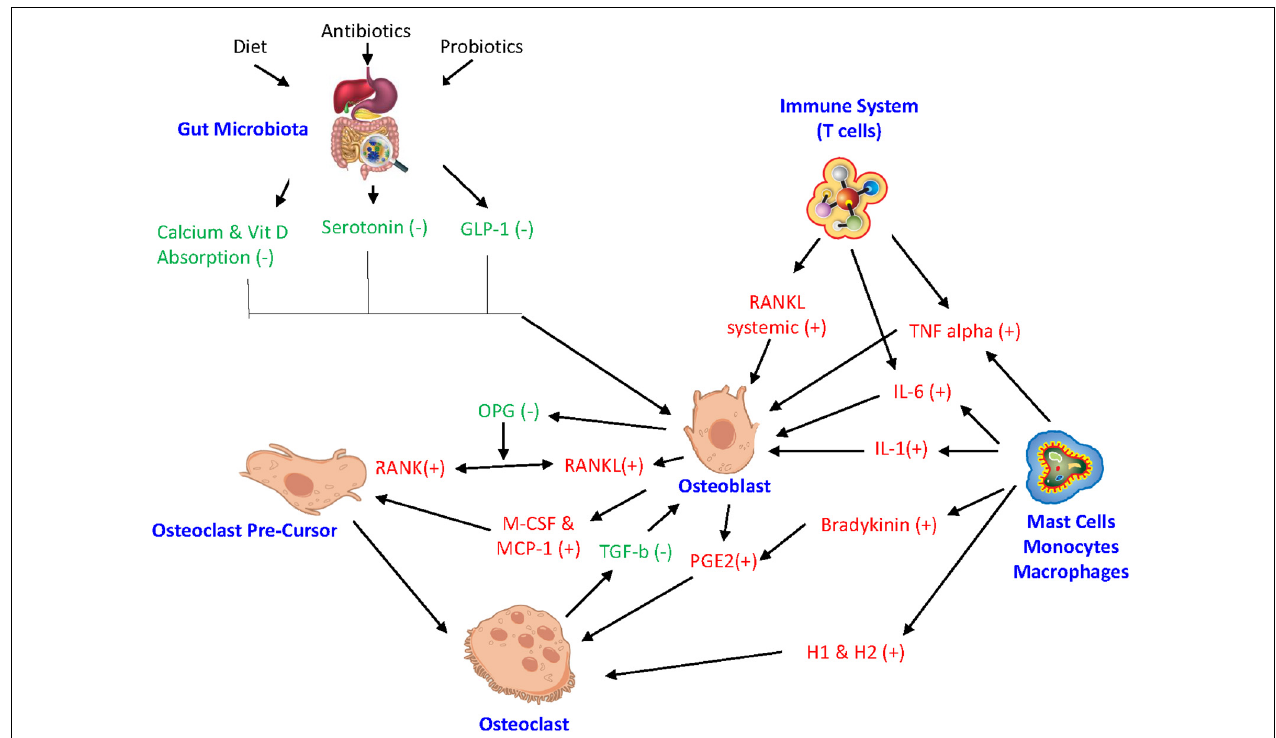
FIGURE 2 | Integrated inflammatory model. The complex link between gut microbiota, hormonal pathways, immune system, and bone turnover. GLP-1 glucagon-like peptide, miRNA microRNA, IL-6 interleukin-6, IL-1 interleukin-1, RANKL receptor activator of NF-kB ligand, RANK receptor activator of nuclear factor-kB, OPG Osteoprotegrin, TNF alpha tumor necrosis factor-alpha, M-CSF macrophage colony stimulating factor, MCP-1 monocyte chemoattractant protein 1, H1 histamine 1, H2 histamine 2, PGE2 Prostaglandin E2. (+) drive osteoclastogenesis or resorption. ( − ) inhibit